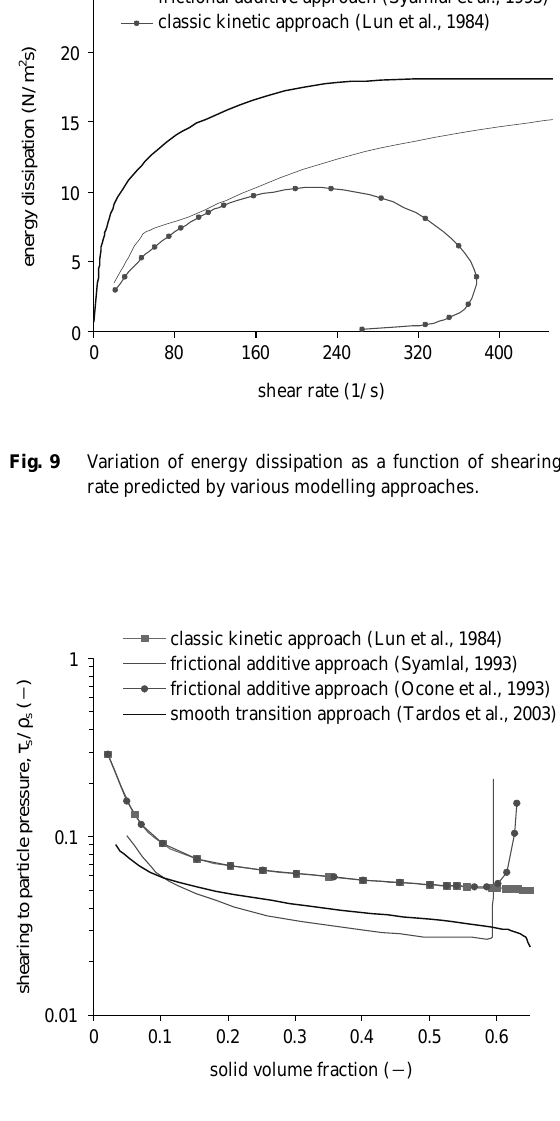
Shearing to particle pressure ratio as a function of con- centration predicted by different modelling